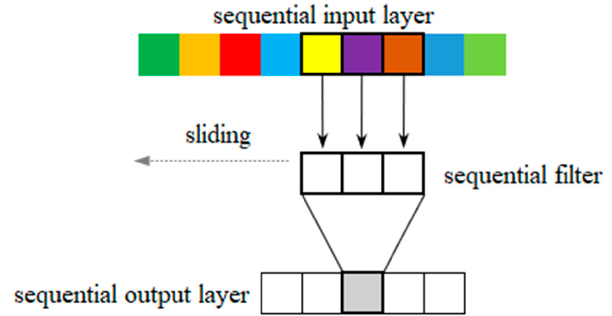
Figure 11. One-dimensional (1D) data convolution.